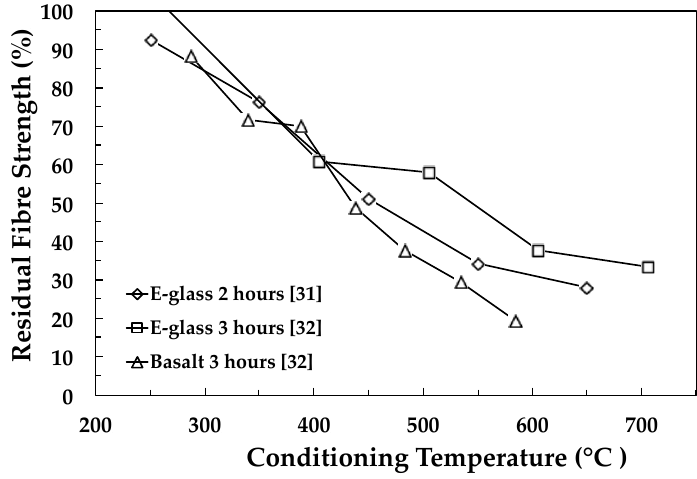
Figure 1. Typical results from the literature on residual fibre strength after heat conditioning.